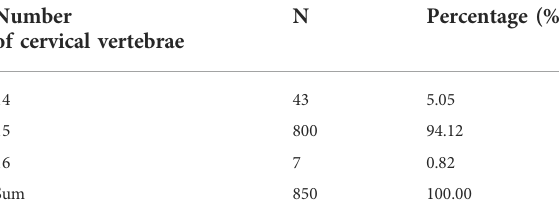
TABLE 2 CVN (number of cervical vertebrae) distribution in the Pekin duck population. Number of cervical vertebrae